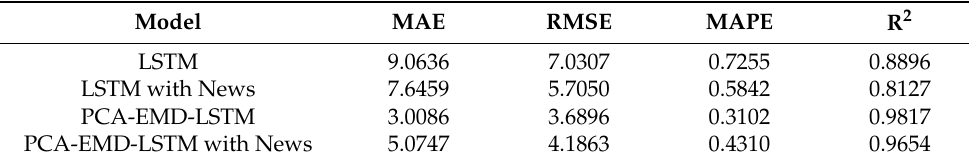
Table 9. Results of the prediction models using news sentiment.